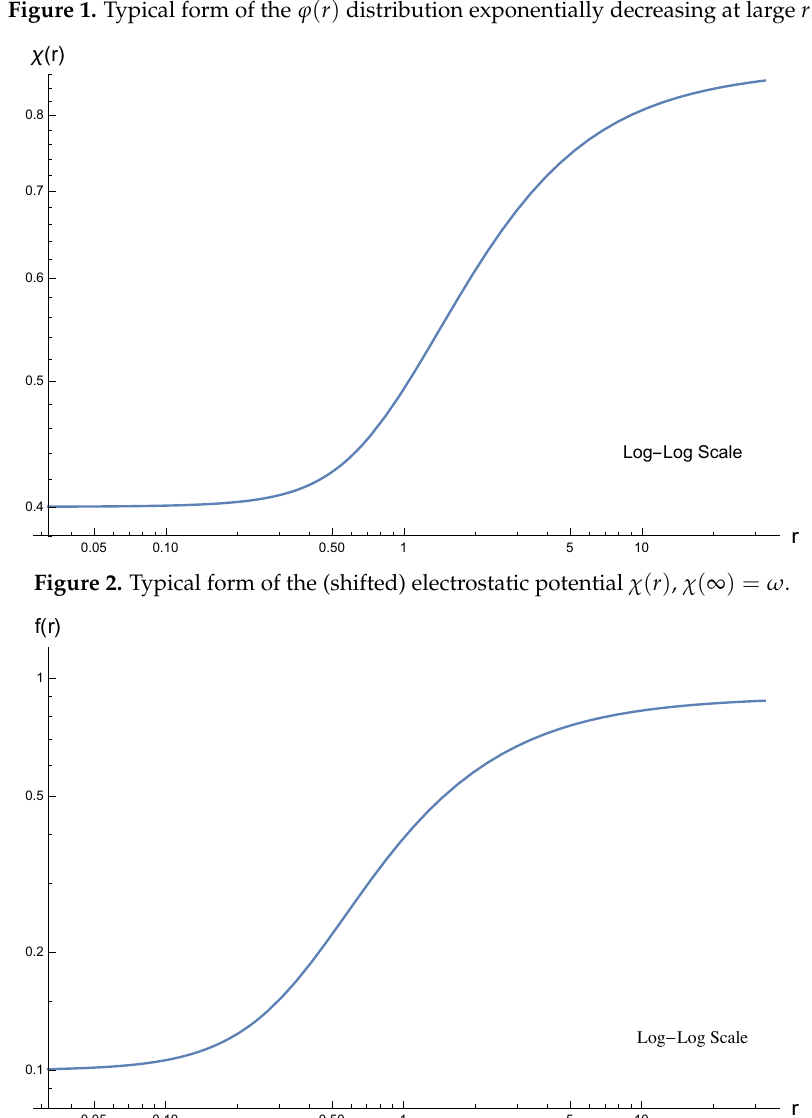
Figure 3. Typical form of a (horizon-free) metric function